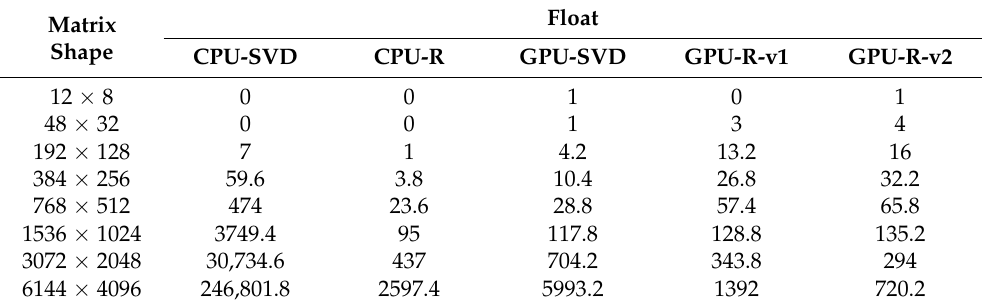
Table 1. Time in milliseconds to calculate the pseudoinverse for float (single precision) matrices. Matrix